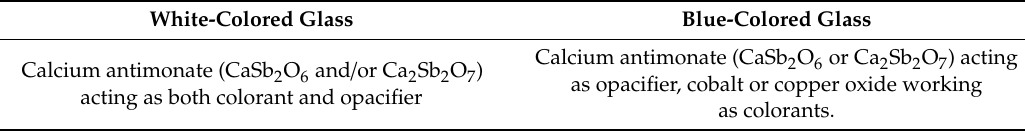
Table 1. Antimony-Based Phases.